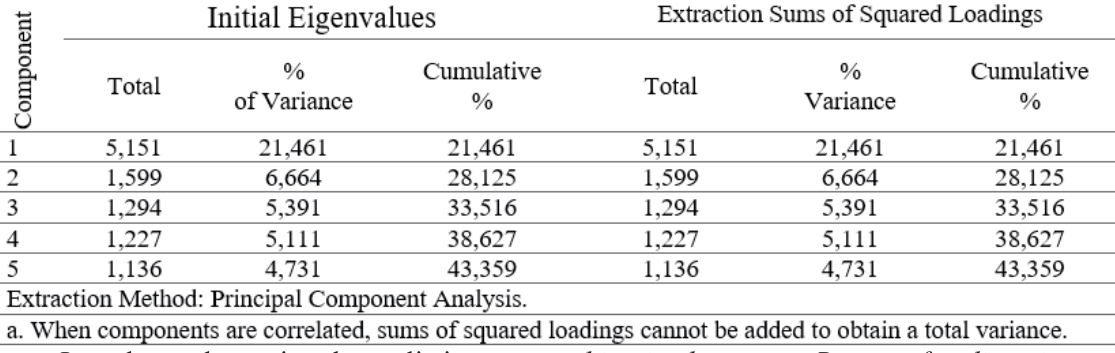
Table 3. Characteristic Roots (LAMBDA) matrix of inter-correlation of social competence